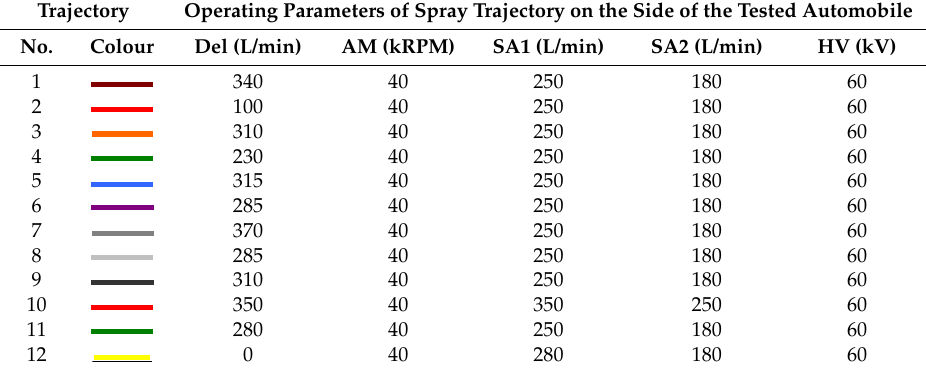
Table 2. Operating parameters of spray trajectory on the side.